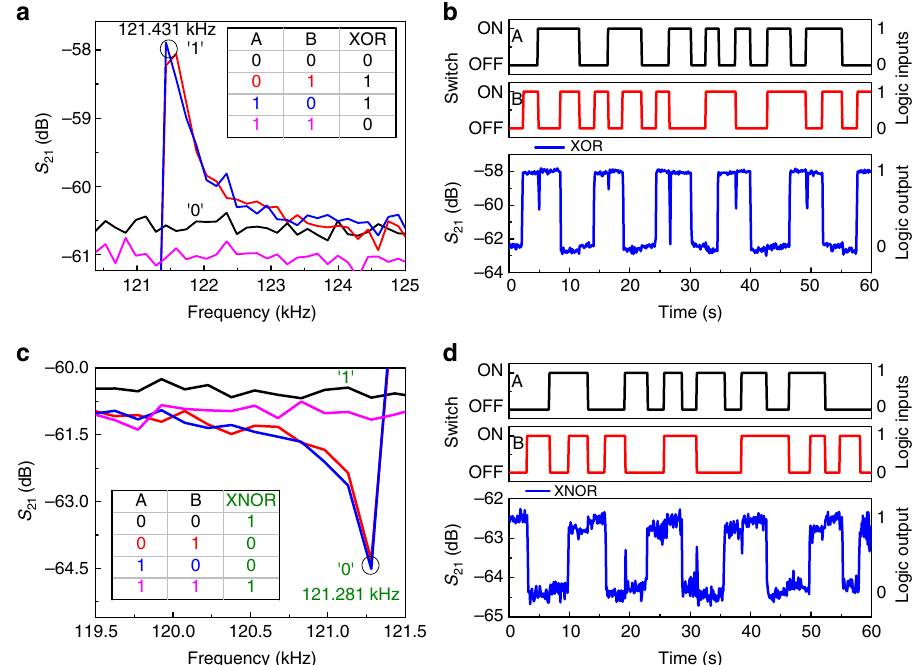
Figure 6 | Demonstration of 2-bit XOR and XNOR logic gates. ( a ) Frequency responses of the resonator for different logic input conditions, where (0,1) and (1,0) logic input condition shown in red and blue has high S 21 transmission signal at 121.43kHz and others have low S 21 transmission signal represented by 1 and 0, respectively. Truth table of XOR logic gate is shown in the inset. ( b ) Demonstration of XOR logic operation when the operation frequency is chosen as 121.43kHz. Two input signals, A and B are shown in black and red, respectively, where the switch OFF/ON corresponds to 0/1 logic input conditions. S 21 transmission signal in blue corresponds to the logic output that fulfills the XOR truth table. ( c ) Frequency responses of the resonator for different logic input conditions, where (0,0) and (1,1) logic input conditions shown in red and blue, respectively, has low S 21 transmission signal at 121.281kHz and others have high S 21 transmission signal represented by 0 and 1, respectively. Truth table of XNOR logic output is shown in the inset. ( d ) Demonstration of XNOR logic operation when the operating frequency is fixed at 121.281kHz. Two input signals, A and B are shown in black and red, respectively, where the switch OFF/ON corresponds to 0/1 logic input conditions. S 21 transmission signal in blue corresponds to the logic output and fulfills the XNOR truth